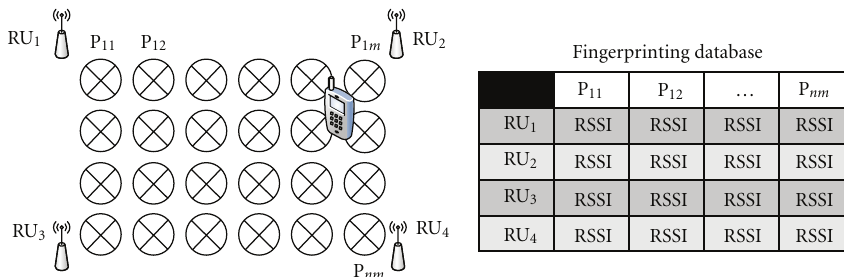
Figure 5: RSS fingerprinting